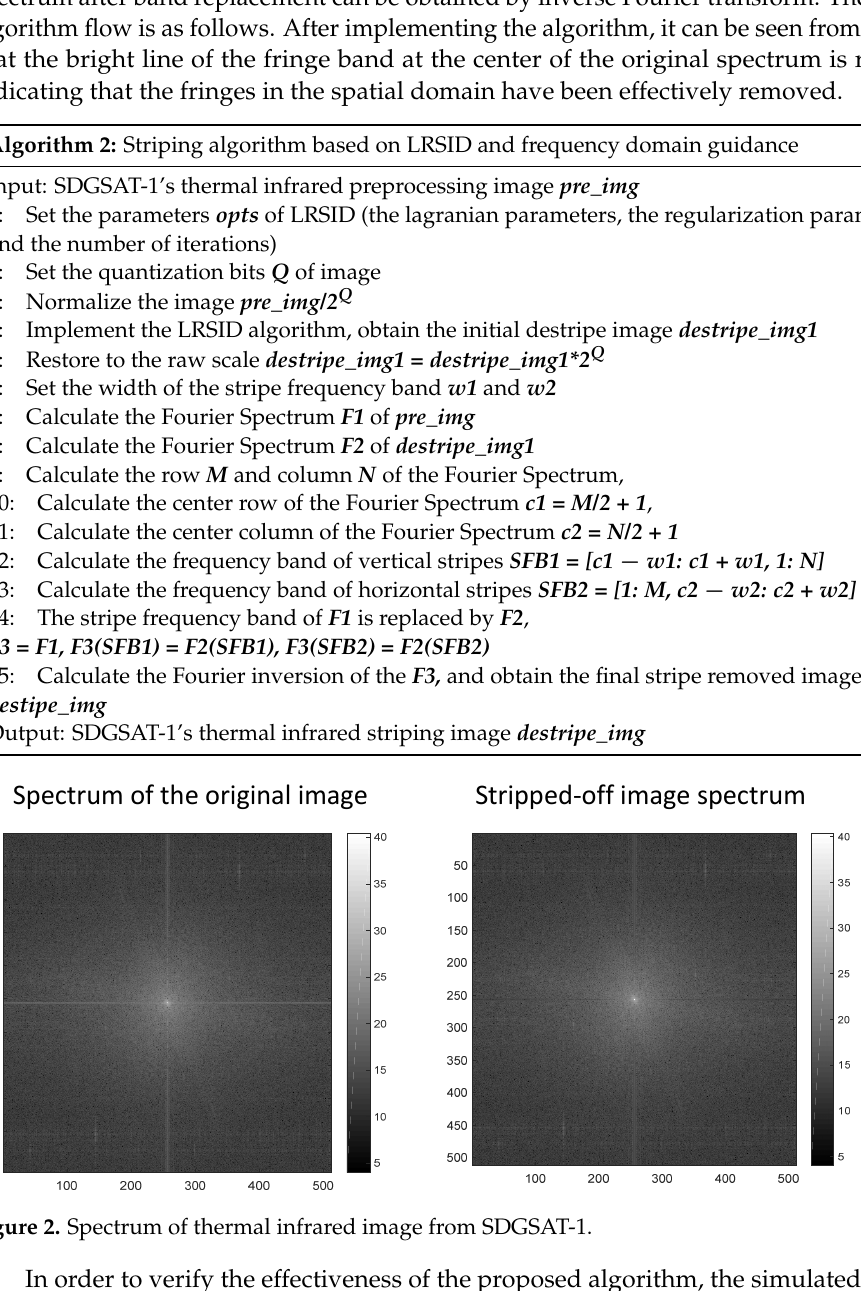
Figure 2. Spectrum of thermal infrared image from SDGSAT ‐ 1.